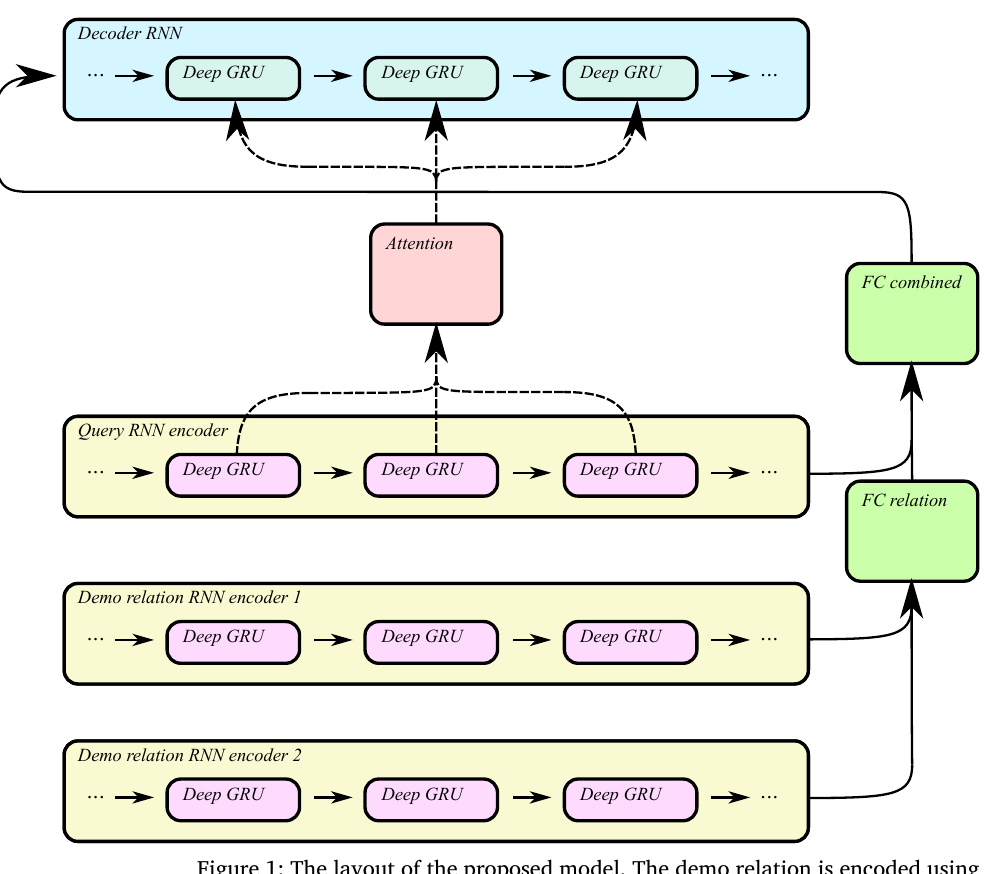
Figure 1: The layout of the proposed model. The demo relation is encoded using two encoder RNNs with shared weights for the two demo word forms. A fully connected (FC) layer FC relation follows the demo relation pair. The query word is encoded separately, and its embedding is concatenated with the output from the fully connected (FC) layer FC relation , and fed as the initial hidden state into the RNN decoder which generates the output while using an attention pointer to the query encoder. In the example see is to sees as eat is to what , see is fed into the demo relation RNN encoder 1 , sees is fed into the demo relation RNN encoder 2 , eat is fed into the query RNN encoder , and the whole model is trained to generate the correct output eats at the decoder RNN